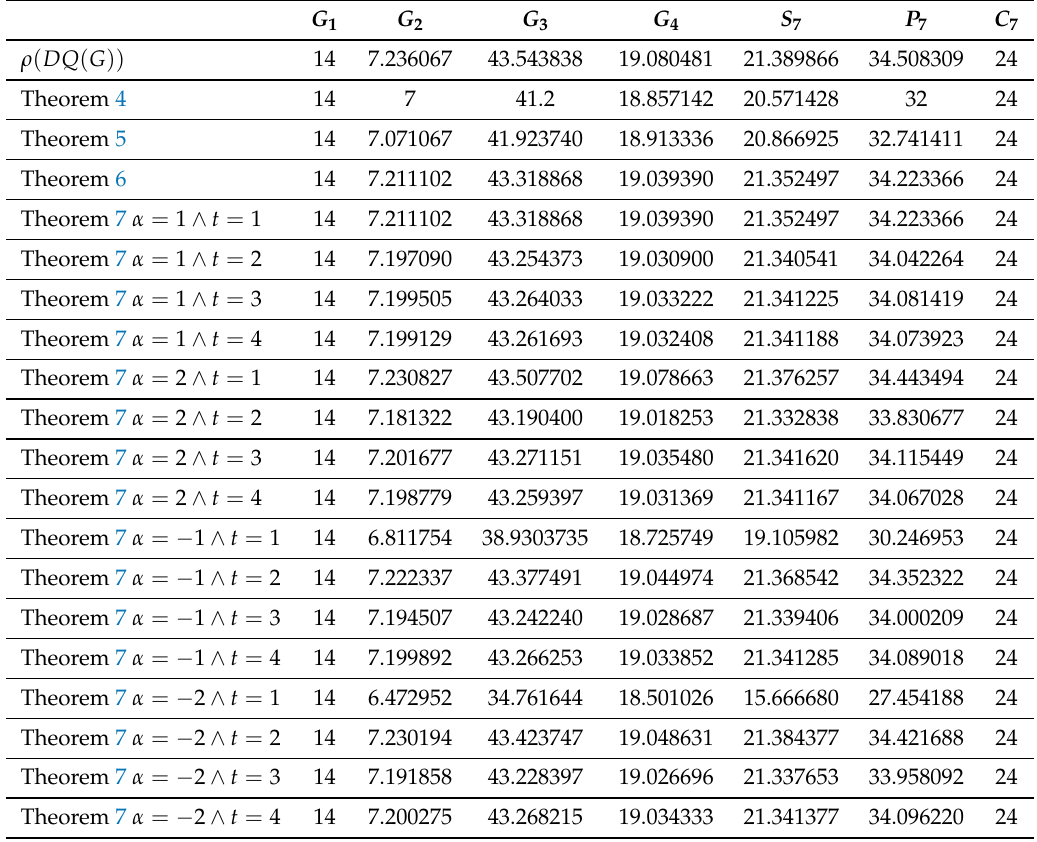
Table 1. Lower bounds for r(DQ(Gi)), using six decimal places, where Gi is given in Figure